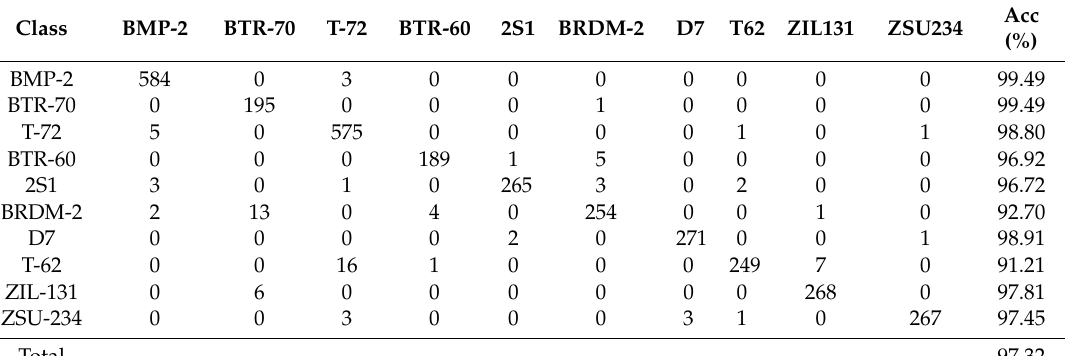
Table 6. Confusion matrix of ESENet under SOC.